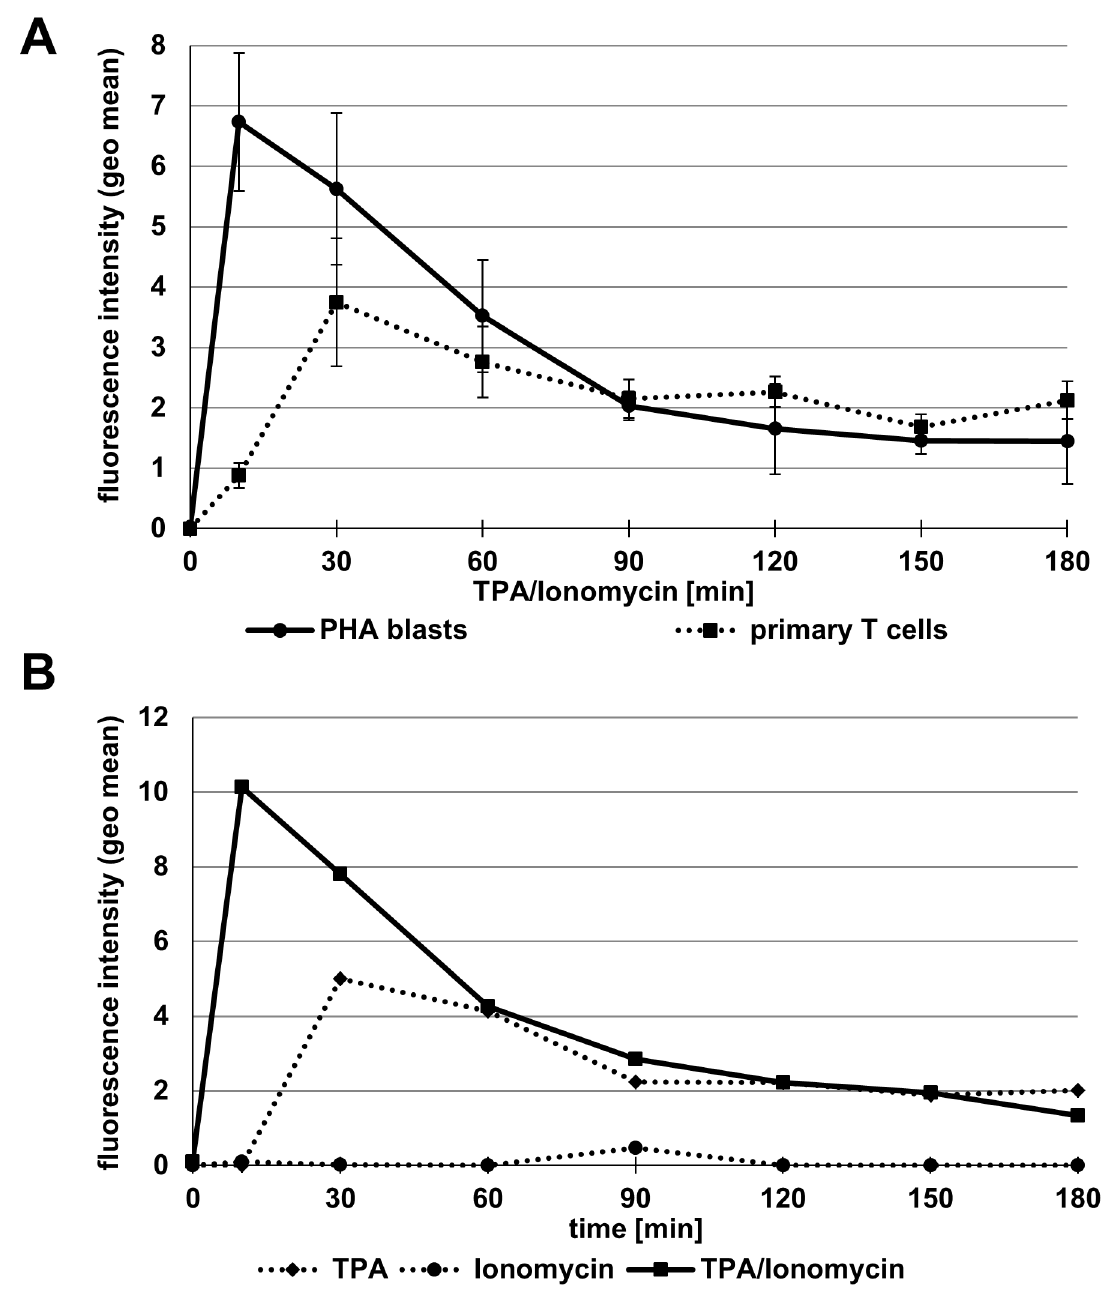
Figure 8. ADAM17 induction in freshly isolated and in vitro . expanded T cells . A. PHA-activated T cell blasts and freshly isolated primary T cells from three different individuals were stained for ADAM17 at the indicated time points after stimulation with TPA and Ionomycin. In all cases, we observed an increase of ADAM17 on the cell surfaces. Mean values (n=3) and error bars are given based on geometric mean values calculated from individual FACS histograms. Apparently, in pre-activated T cell blasts ADAM17 induction is more rapid and reaches a higher amplitude as compared to freshly isolated T cells. B. In order to address the role of TPA versus Ionomycin for the induction of ADAM17, PHA blasts were stained for anti-ADAM17 at the indicated time points after stimulation with either TPA or Ionomycin or both stimuli. Data are shown as geometric mean values for one representative experiment.